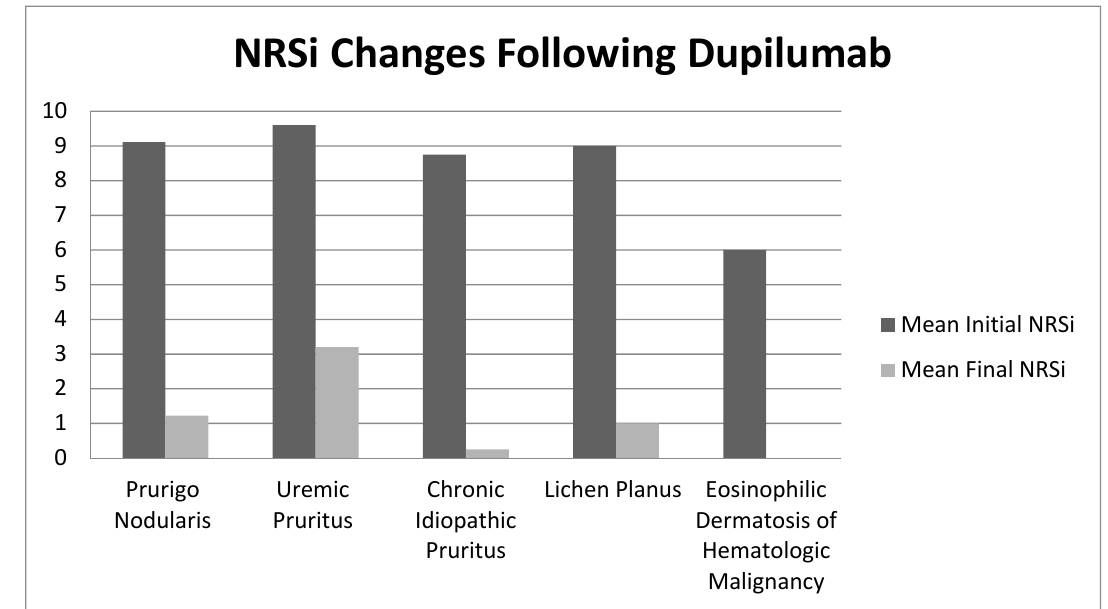
Figure 1. Numeric rating scale itch intensity (NRSi) changes following dupilumab.